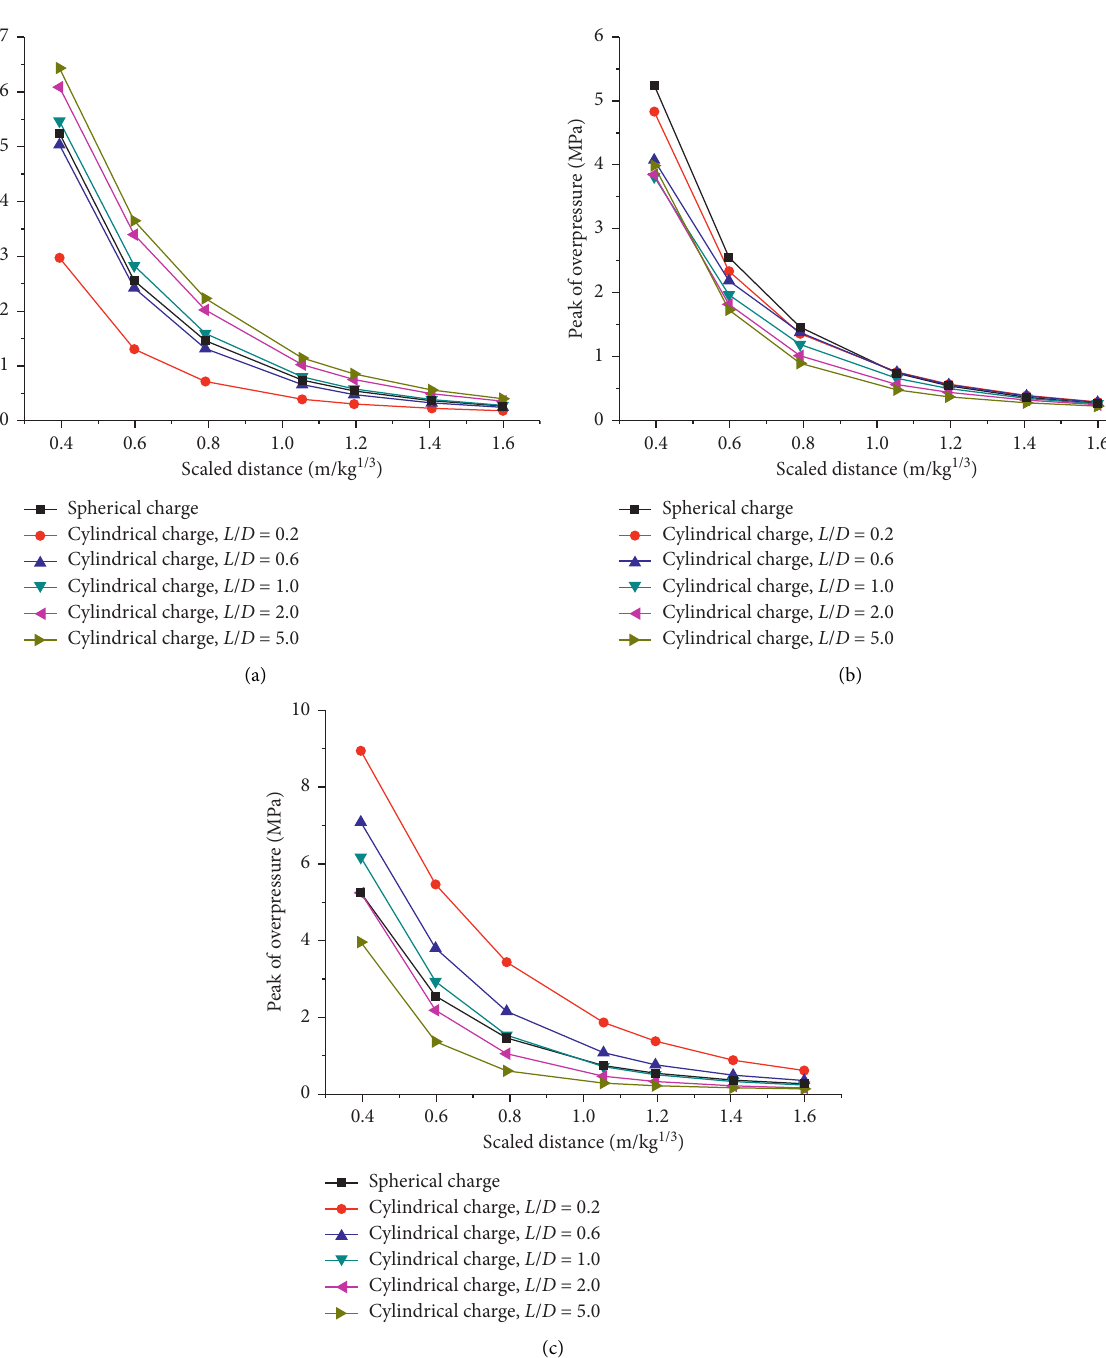
Figure 7: Comparison of the peak overpressure from spherical and cylindrical explosives. (a) Radial direction. (b) 45 ° direction. (c) Axial